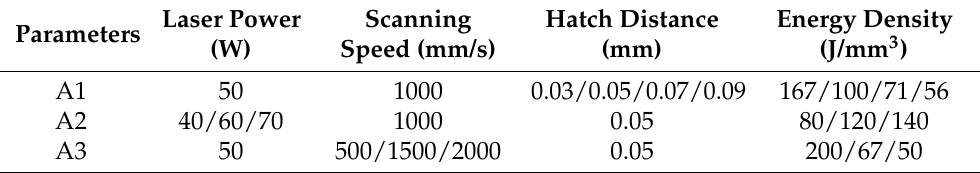
Table 2. The parameters adopted for optimization of printing cubes with different energy densities.